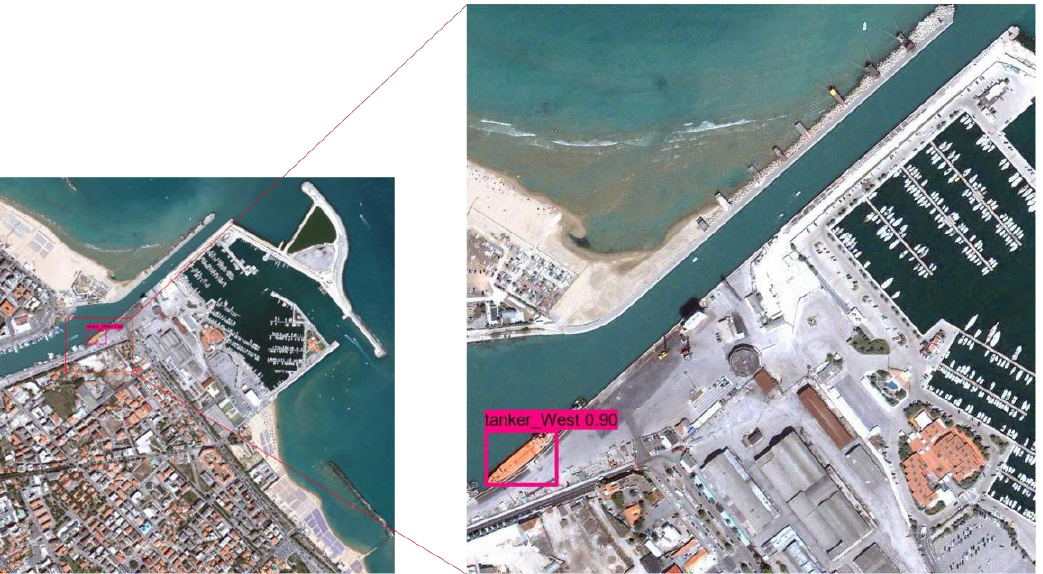
J. Mar. Sci. Eng. 2021 , 9 , x FOR PEER REVIEW Figure 12. The Deimos-2 image of Dalian Port. Figure 12. The Deimos-2 image of Dalian Port.